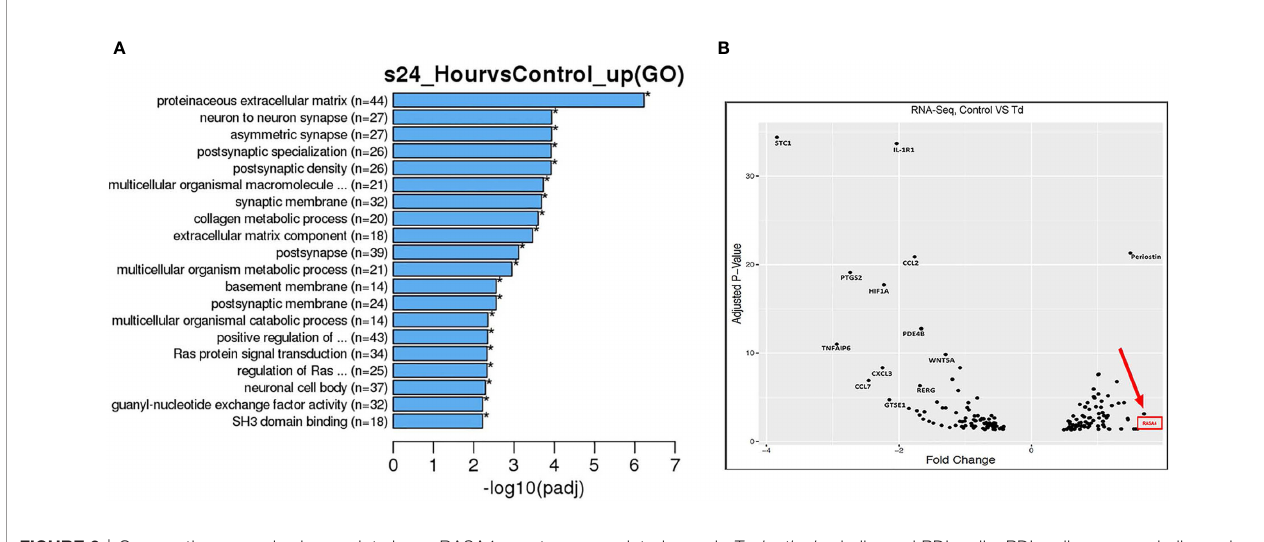
FIGURE 3 | Gene pathways and volcano plot shows RASA4 as a top upregulated gene in T. denticola challenged PDL cells. PDL cells were unchallenged or challenged with T. denticola (50 MOI) for 24 h and differential gene expression analysis was performed using RNA-Seq. 165 genes were identi fi ed from the gene ontology pathways derived from the RNA sequencing data. Biological processes were identi fi ed from the top signi fi cant processes that were differentially regulated in the gene ontology enrichment analysis from 5 h and 24 h gene ontology graphs ( Supporting Information , Figure 3 and A ). Pathways identi fi ed were titled regulation of actin fi lament organization, positive regulation of cell projection organization, regulation of actin fi lament organization, ras protein signal transduction, regulation of small GTPase meditated signal transduction, extracellular matrix component, and extracellular matrix organization. Based on these pathways, the top genes were identi fi ed and their adjusted p-value and differential expression was plotted as a volcano plot (B) . All genes used in the volcano plot came from the 24 h challenge data sets within the pathways speci fi ed above. RASA4 was identi fi ed as one of the top genes upregulated upon 24 h T. denticola challenge.